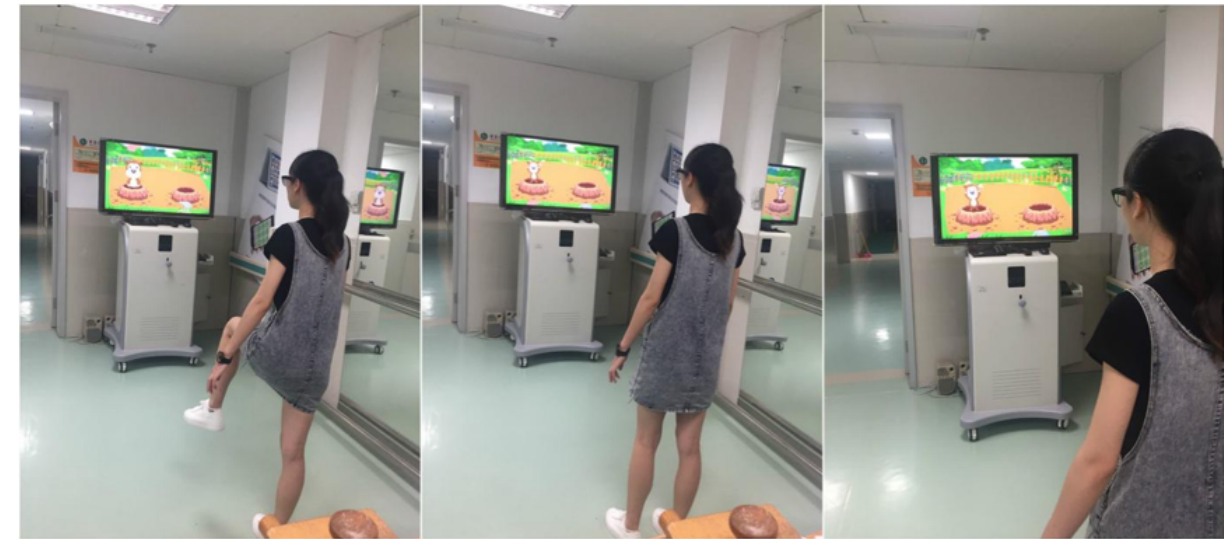
Figure 1. A participant experiencing Stomp